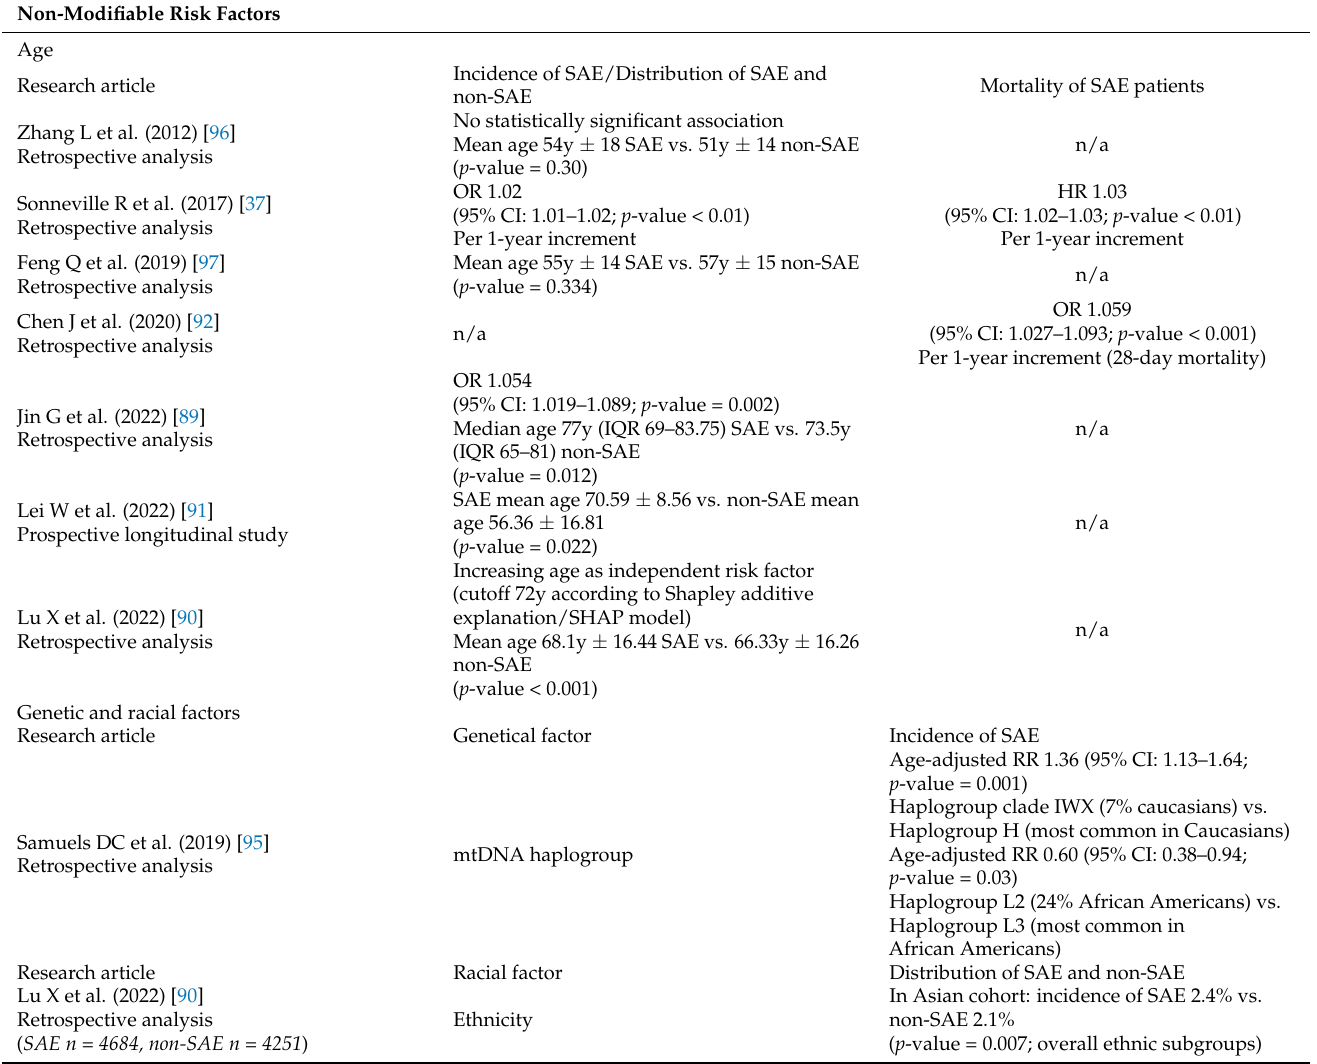
Table 1. Non-modifiable risk factors of